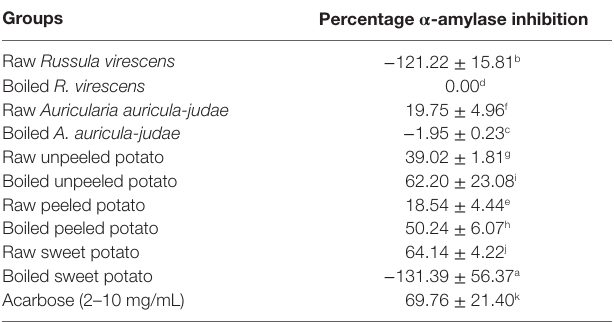
Table 2 | α -Amylase inhibitory properties (%) of aqueous extracts of raw and boiled mushrooms, potato, and sweet potato. groups